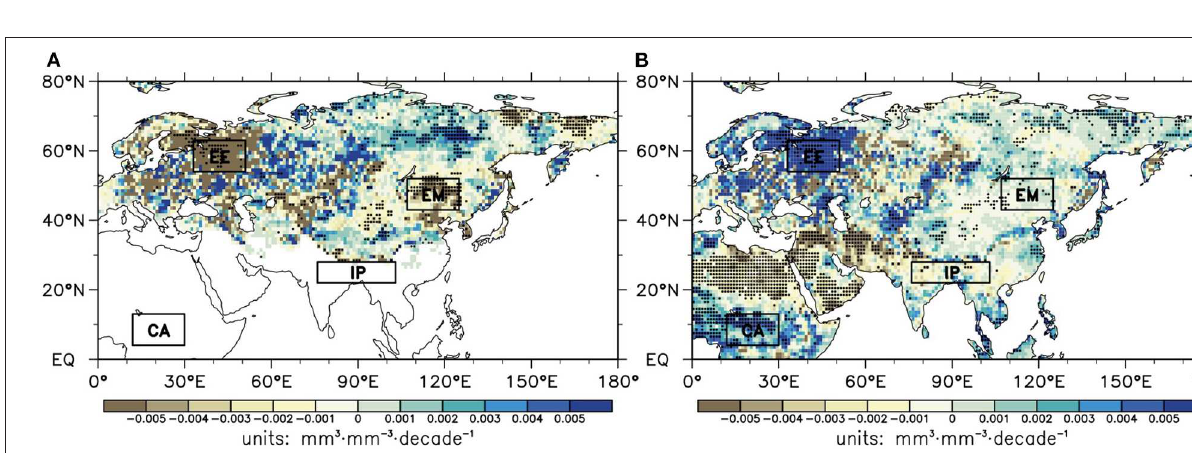
FIGURE 4 | Same as Figure 1 , but for (A) soil ice and (B) soil liquid